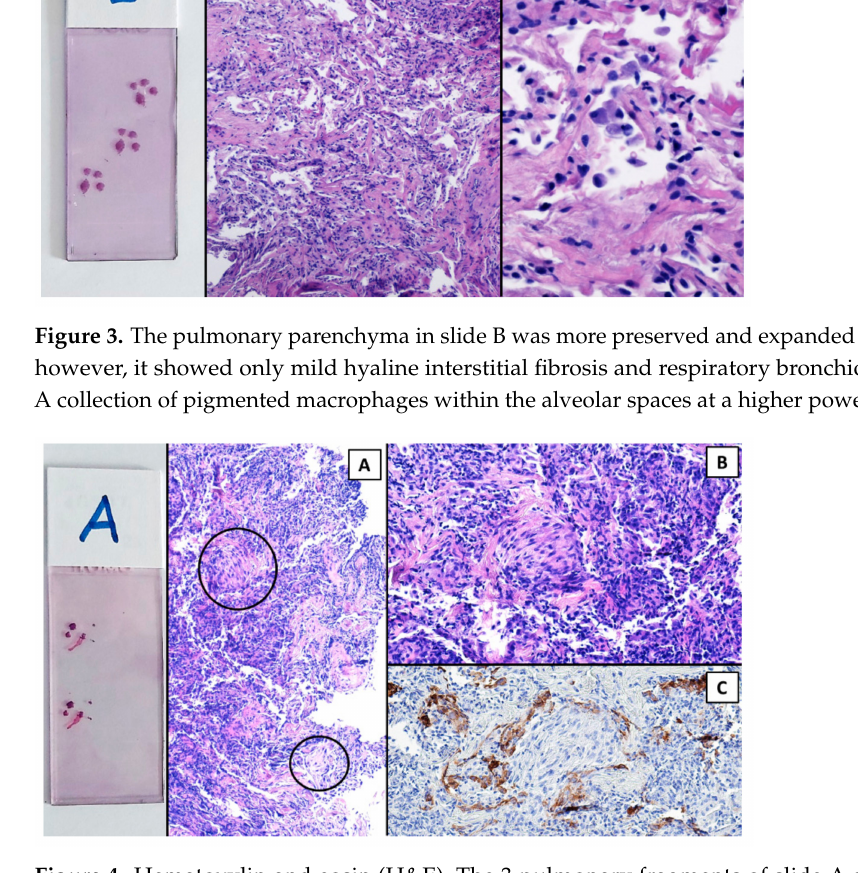
Figure 4. Hematoxylin and eosin (H&E). The 3 pulmonary fragments of slide A showed marked artifactual atelectasis; however, a few small but defined foci of organizing pneumonia emerged (within circles, ( A )). ( B ) H&E, 20 × . A myxoid plug of connective tissue intermingled with inflammatory cells. ( C ) The positive immunohistochemical reaction for cytokeratin in alveolar pneumocytes demonstrated that the focus of organizing pneumonia was within the alveolar space.